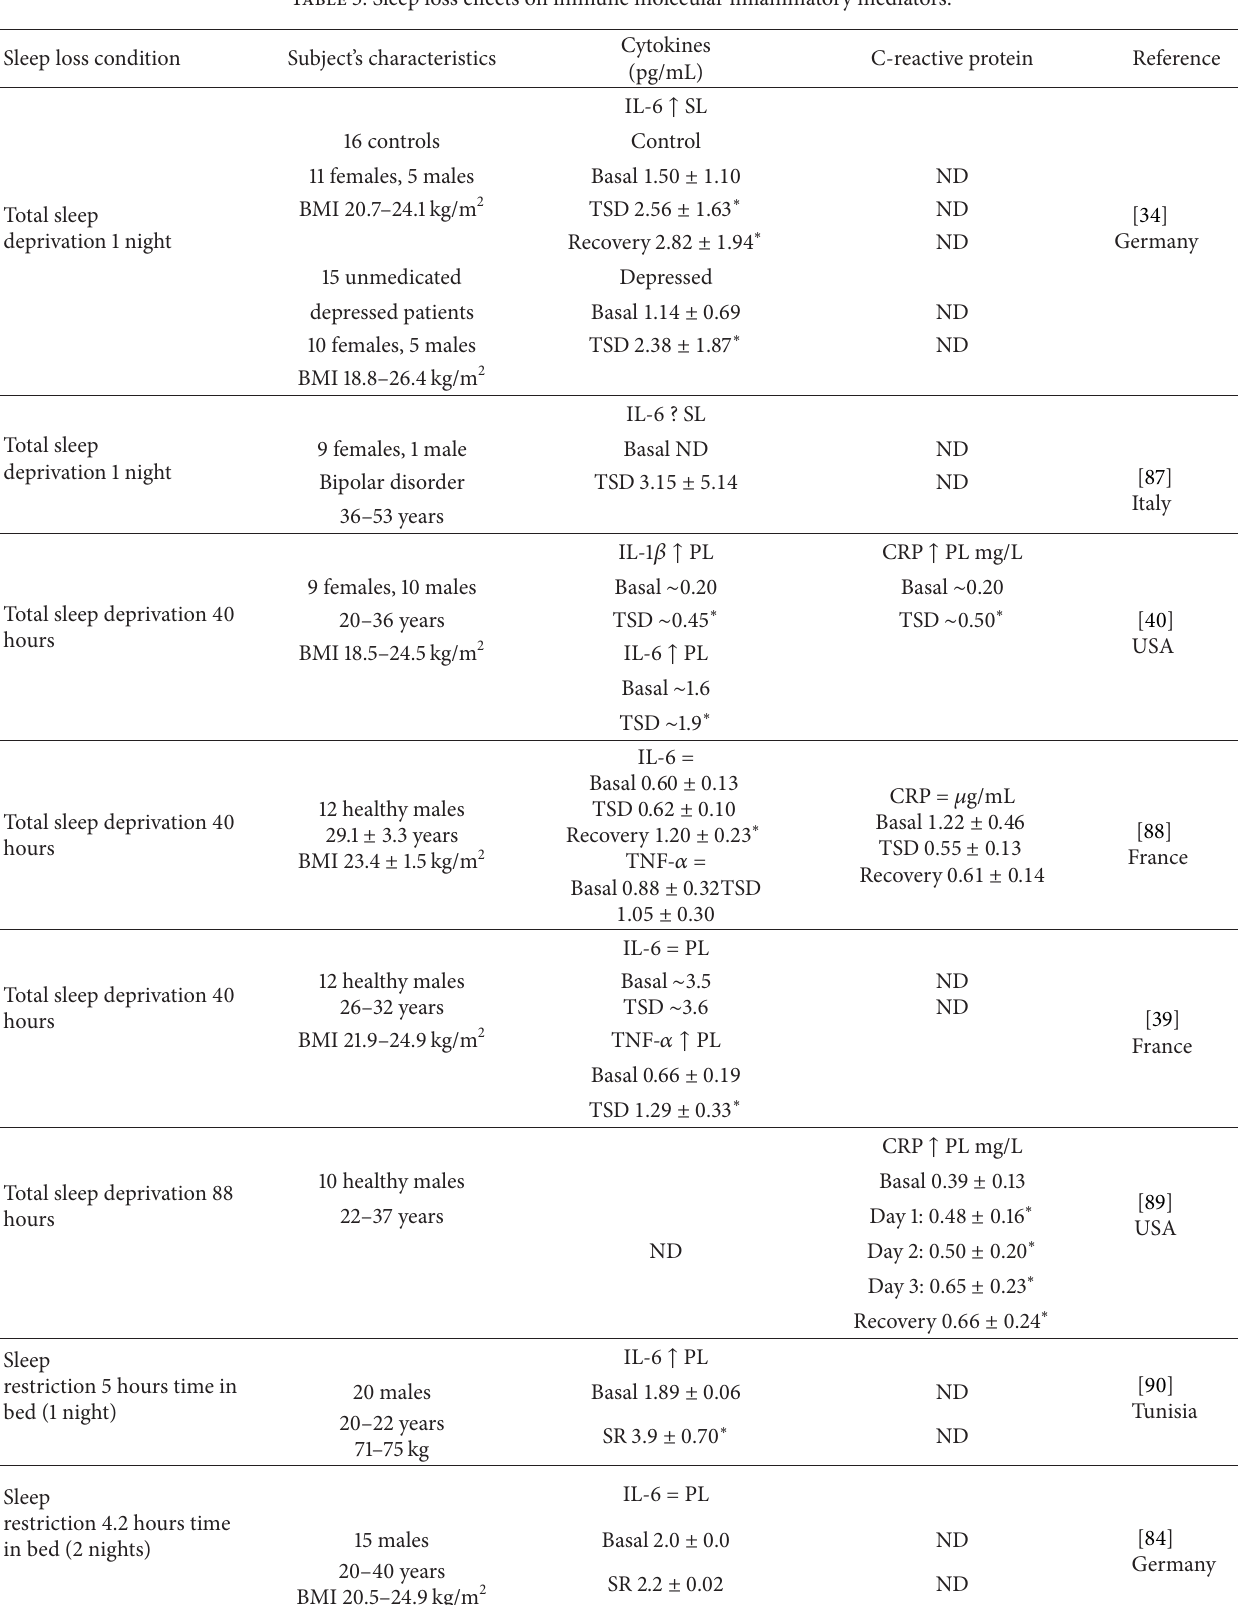
Table 3: Sleep loss effects on immune molecular inflammatory